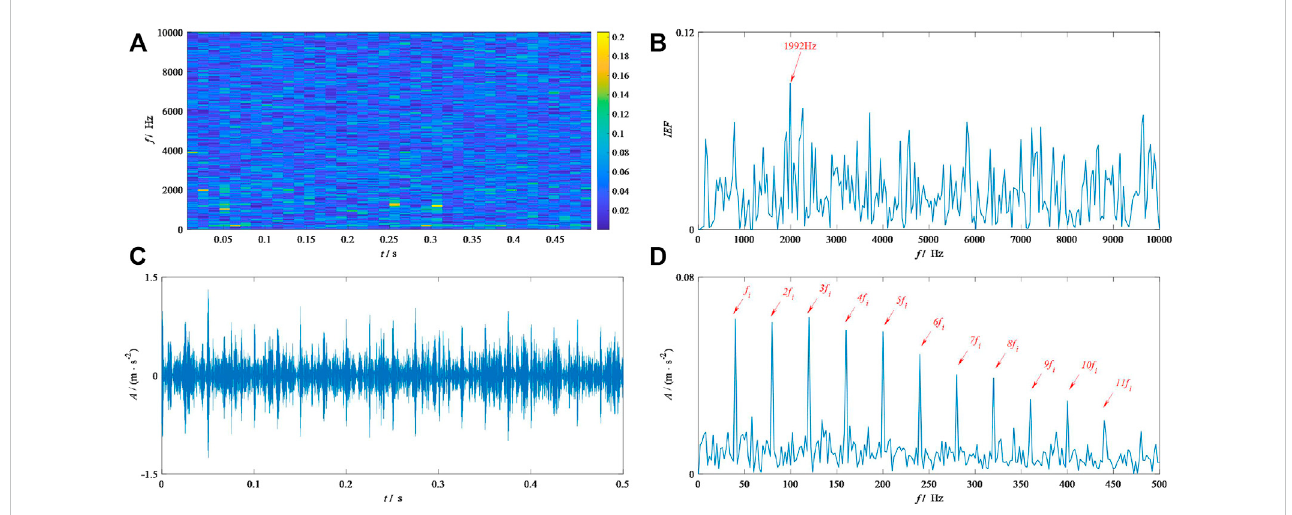
FIGURE 4 Results by the IEFI – MVMD of the simulation signal: (A) STFT, (B) IEFI, (C) TDW, and (D) SES.